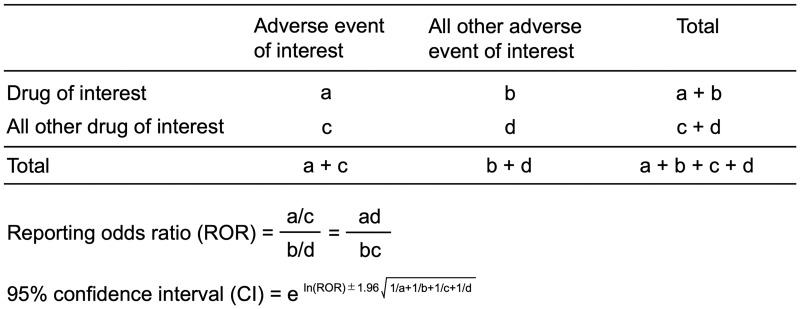
Two by two contingency table for analysis.